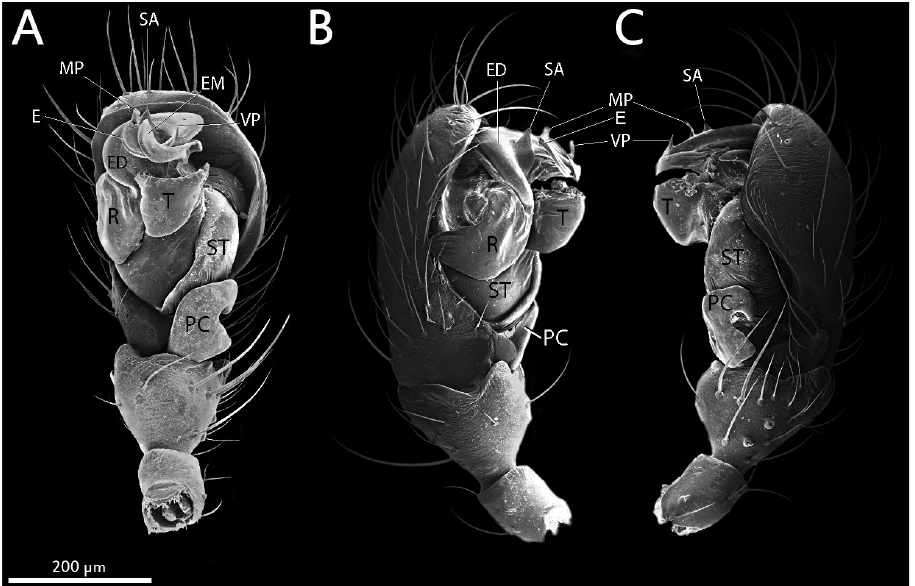
Figure 3. SEM micrographs of the left palp of Islandiana lewisi sp. n. A Ventral B Medial C Lateral. E = Embolus; ED = Embolic division; EM = Embolic membrane; MP = medial projection of ED; VP = ventral projection of ED; R = radix of ED; SA = suprategular apophysis; ST = subtegulum; T = tegulum; PC =